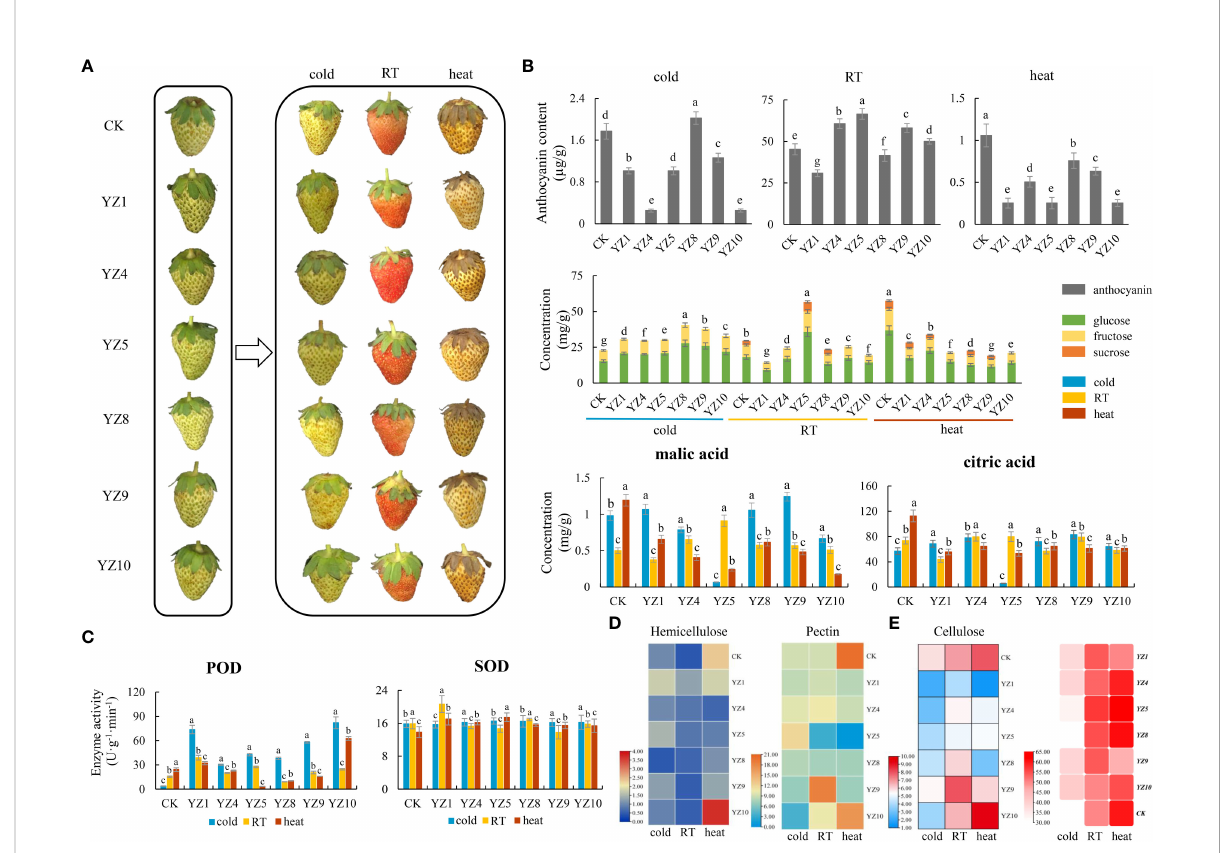
FIGURE 7 Physiological and biochemical changes in the fruits of YZs-overexpressing strawberry. (A) YZs were overexpressed in strawberry fruits treated with different storage temperatures like cold (4°C), heat (37°C), and room temperature (25°C). YZ1: Hsp20/alpha crystallin family; YZ4: Universal stress protein family; YZ5: Senescence regulator; YZ8: EF-hand domain pair; YZ9: Histone-like transcription factor (CBF/NF-Y) and archaeal histone; YZ10: Protein phosphatase 2C; (B) The changes of the content of anthocyanin, sugars (glucose, fructose, and sucrose), and acids including malic and citric acid; (C) The changes of the activity of SOD and POD; (D) Heat map analysis of the changes of the content of cellulose, hemicellulose, and pectin; (E) Heat map of the berry